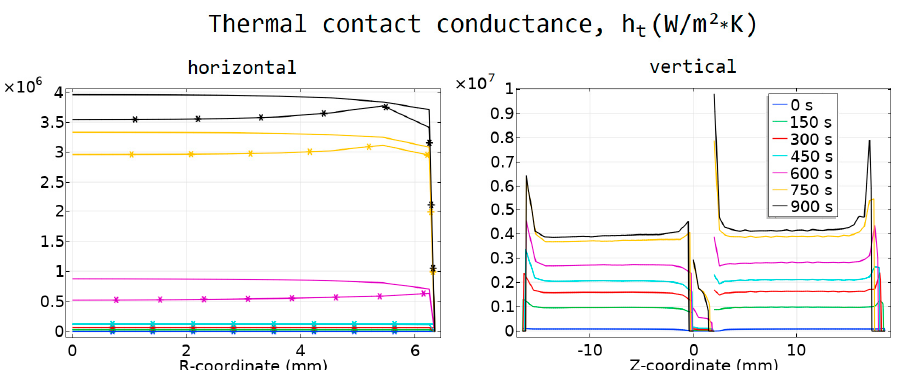
Figure 8. Thermal conductance of the contacts. (a) Contacts IV and V; asterisk markers correspond to the contact IV, solid line to contact V. ( b ) Contacts I – III.